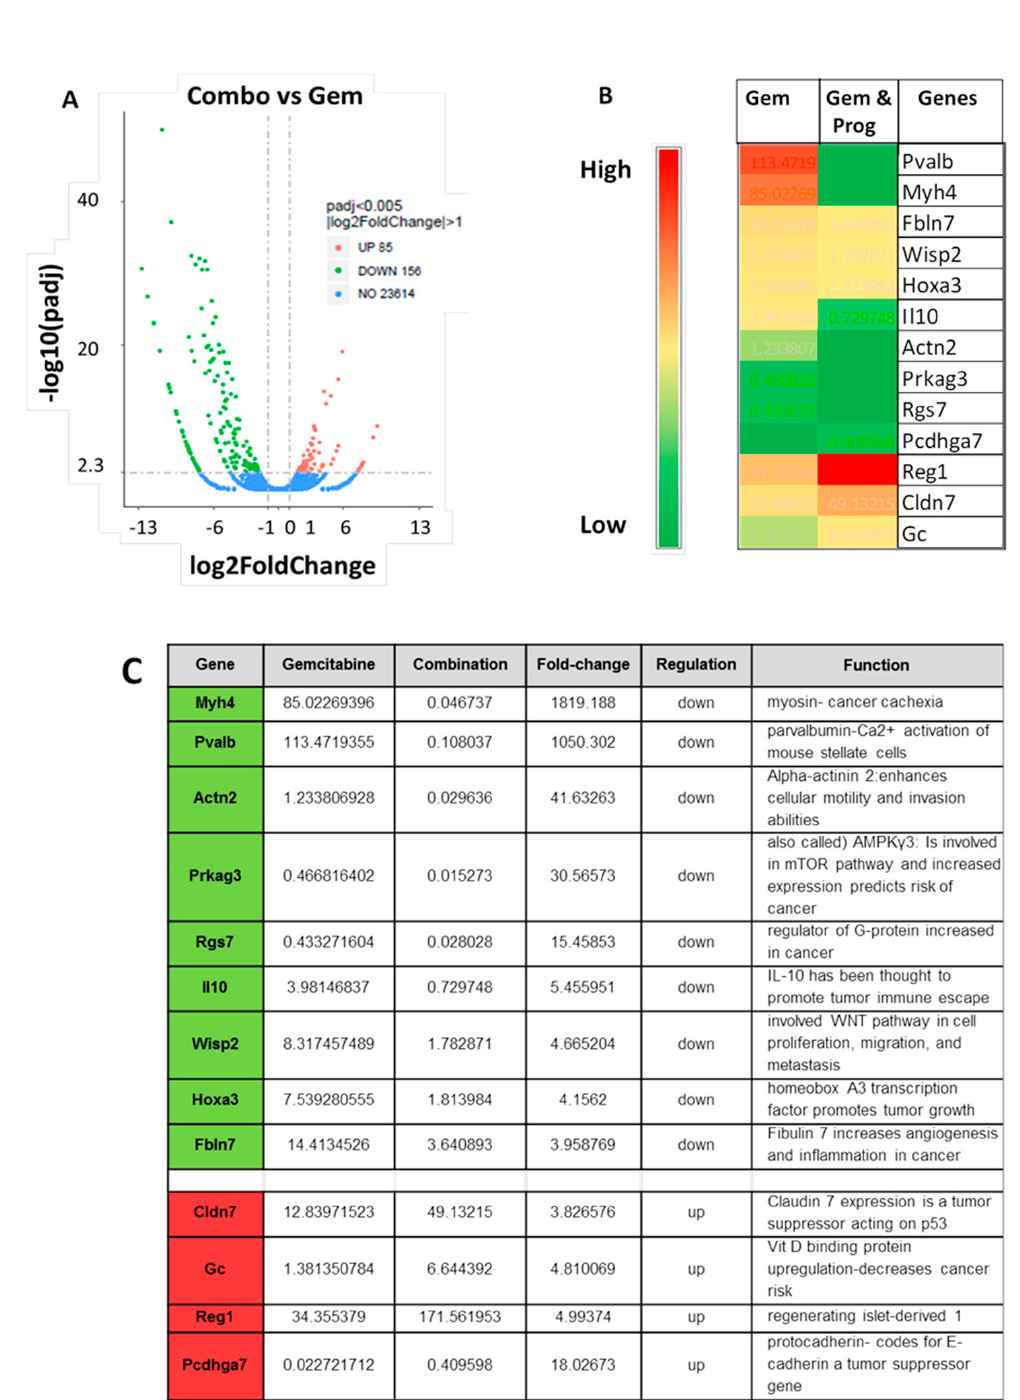
Figure 5. Differentially expressed genes (DEGs) in tumors of mice treated with gemcitabine therapy versus combination therapy. ( A ) Volcano plot of 85 genes that are upregulated Log2-fold in the combination therapy group compared to gemcitabine monotherapy are shown in red dots to the right of the midline. Those 156 genes that are downregulated by the addition of proglumide to gemcitabine in pancreatic tumors are shown in green dots to the left. ( B ) Heat map of 13 novel genes that differentially expressed in pancreas tumors of mice treated with the combination therapy compared to gemcitabine monotherapy. Scale bar is placed to the left with red and green representing highly versus lowly expressed genes based on FPKM values, respectively. ( C ) Table of the 13 novel selected differentially expressed genes that are significantly up or downregulated by combined therapy compared to gemcitabine monotherapy and their known